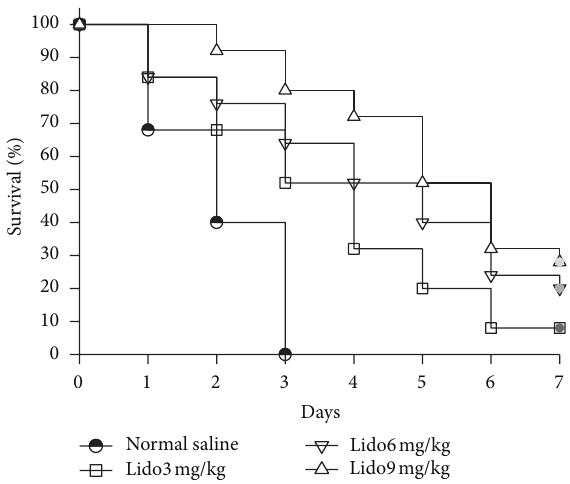
Figure 2: Lidocaine treatment improves the survival of CLP- induced septic rats. The seven-day survival rates were performed on rats treated with NS or lidocaine. Log-rank analysis demonstrated a significant improvement in survival for lidocaine 3, 6, and 9mg/kg versus NS ( 𝜒 2 = 13.309 ; 𝜒 2 = 19.145 ; 𝜒 2 = 34.786 , 𝑃 < 0.001 ). NS: normal saline; Lido: lidocaine.